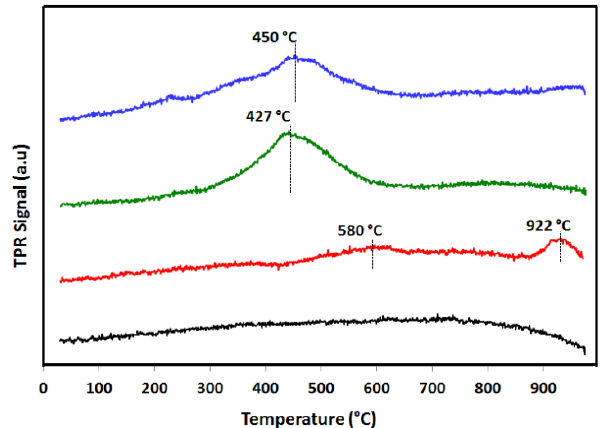
Figure 4. Temperature-programmed reduction (TPR) of alumina ( — ); Fe/Al Pt/Al O 0.5% ( — ) and Pt-Fe/Al 2 3